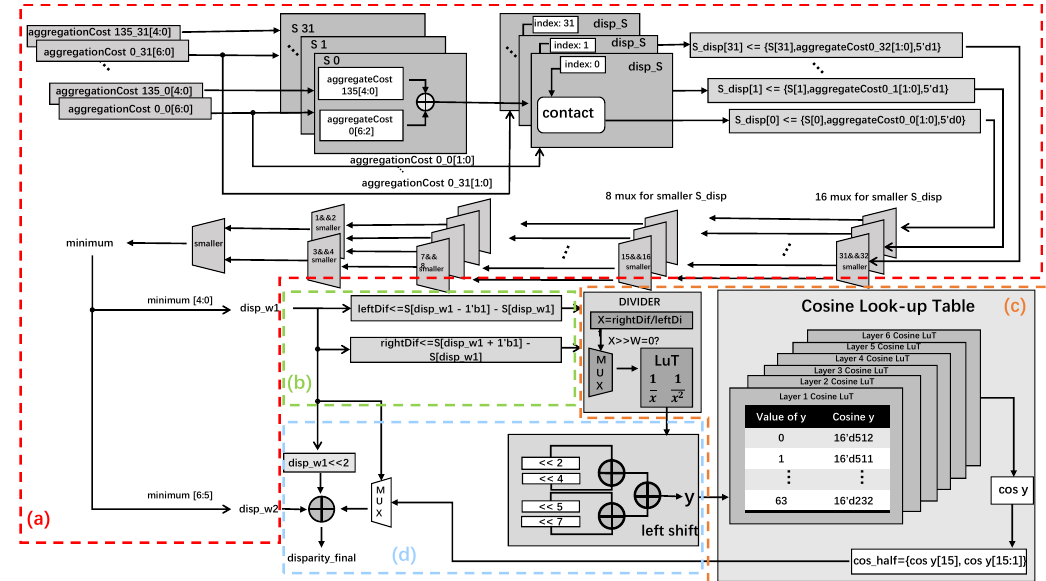
Figure 8 . Subpixel interpolation for disparity computation .